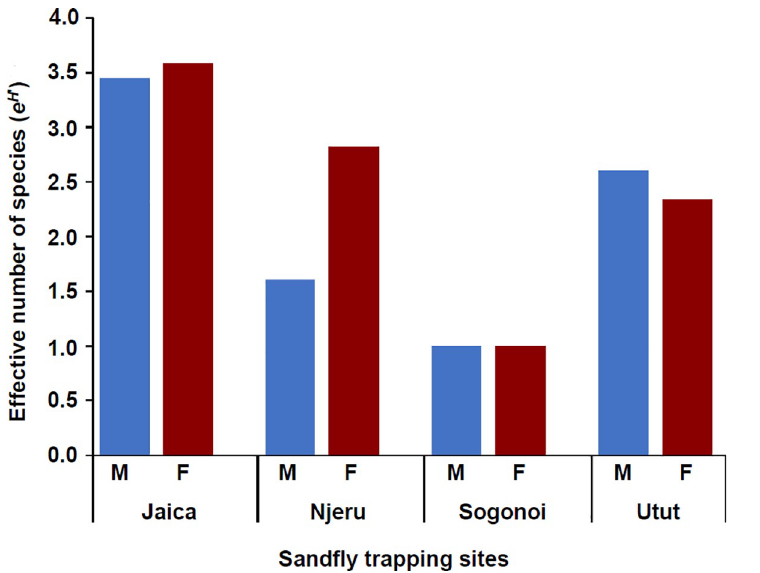
Fig 2. Sandfly species diversity across the sampling sites in Gilgil. M: male; F: female.